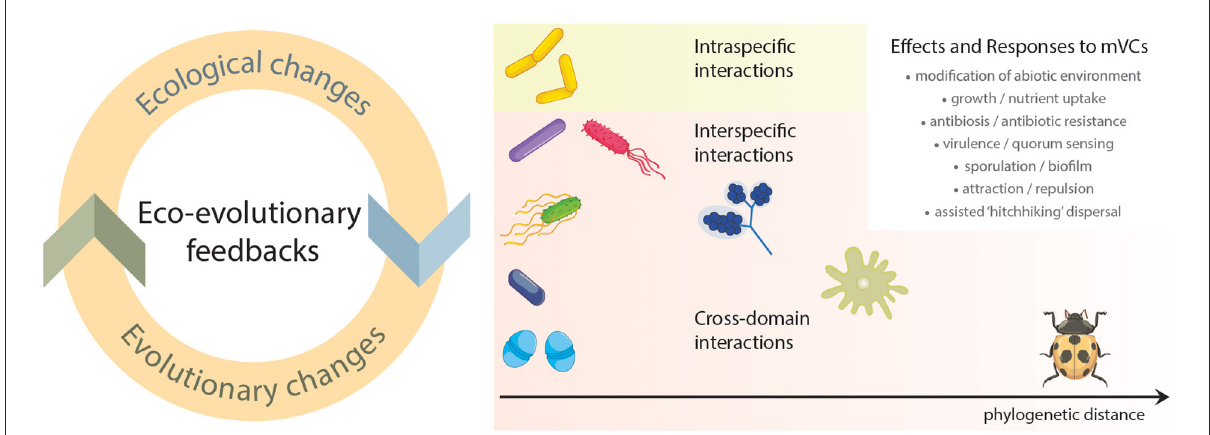
FIGURE1 Schematic representation of mVCs mediating eco-evolutionary dynamics. The left panel displays a simplified diagram of an eco-evolutionary feedback. In brief, these occur when ecological changes sequentially impact evolutionary trajectories of interacting organisms, which in turn lead to changes in their ecological interactions. The right panel depicts (micro)organisms ecological interactions at increasing phylogenetic distances, i.e., form intraspecific (same species) to cross-domain